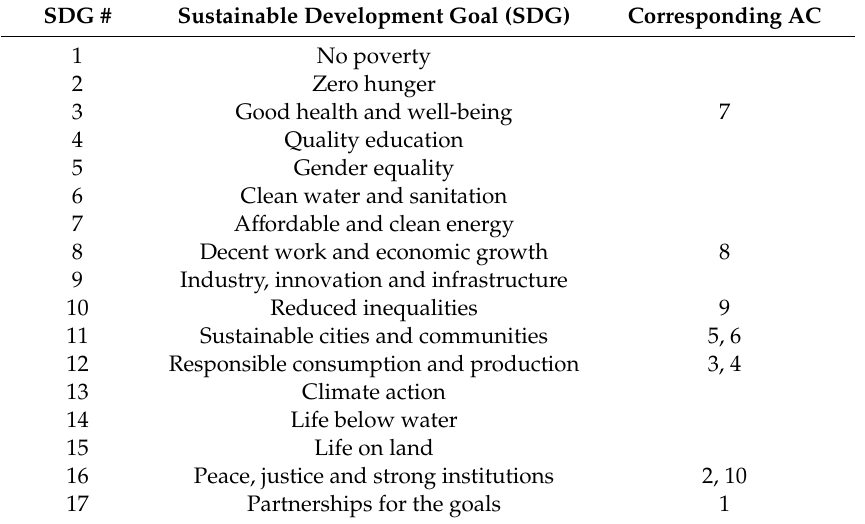
Table 2. Relationship between the SDGs and Aalborg Commitments